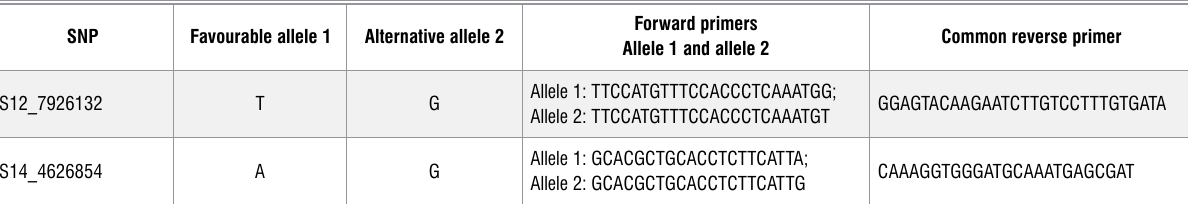
Kompetitive allele-specific PCR primers for single nucleotide polymorphism (SNP) markers associated with cassava mosaic disease resistance SNP Favourable allele 1 Alternative allele 2